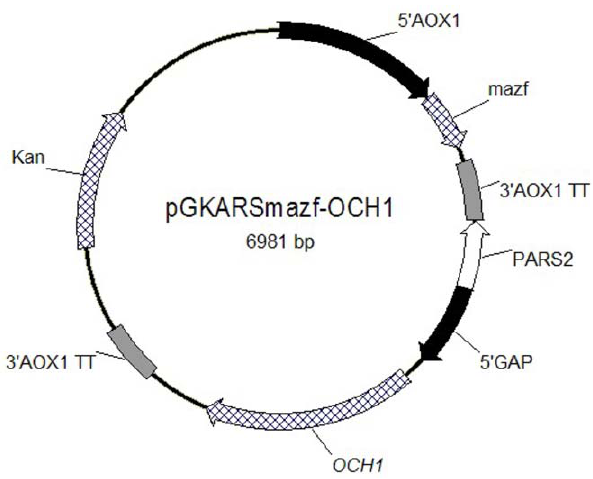
Figure 3. Schematic representation of the helper plasmid. pGKARSmazf-OCH1, the helper plasmid for OCH1 gene deletion, was used as an illustrative example. This plasmid consists of three key elements, the Pichia pastoris autonomous replication sequence (PARS2) fragment (allows plasmid maintenance within the cells), the strong constitutive glyceraldehyde-3-phosphate dehydrogenase (GAP) pro- moter, and the mazf expression cassette (facilitates plasmid removal when